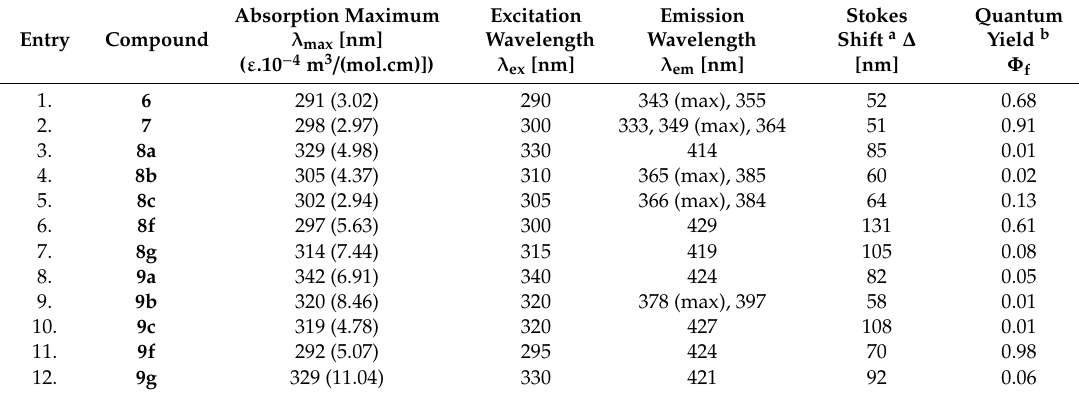
Table 4. Absorption and fluorescence spectral parameters of the investigated compounds, 6 , 7 , 8a-c , 8f-g , 9a-c , 9f-g